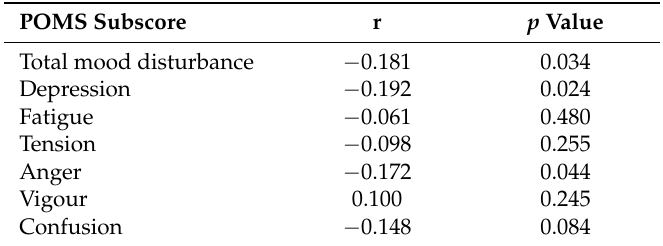
Table 2. Pearson linear correlations of plasma vitamin C with mood.